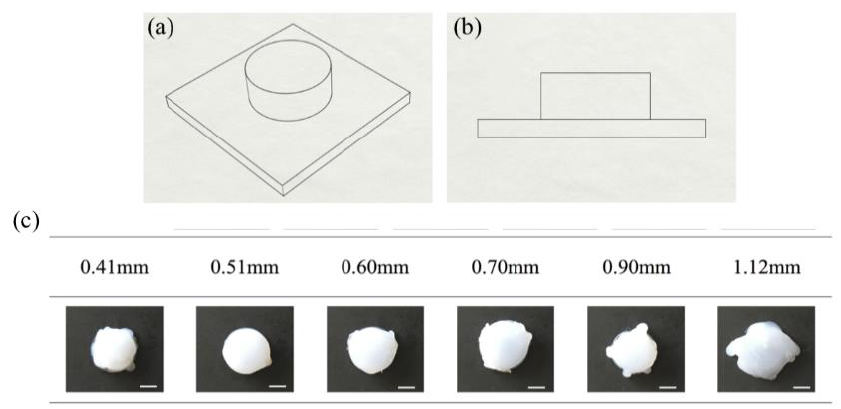
Figure 7. Schematic illustration of 3D printed cylinder ( a ) overview and ( b ) side view. ( c ) Cross-sectional images of the cylinder. Scale bar 1 cm.